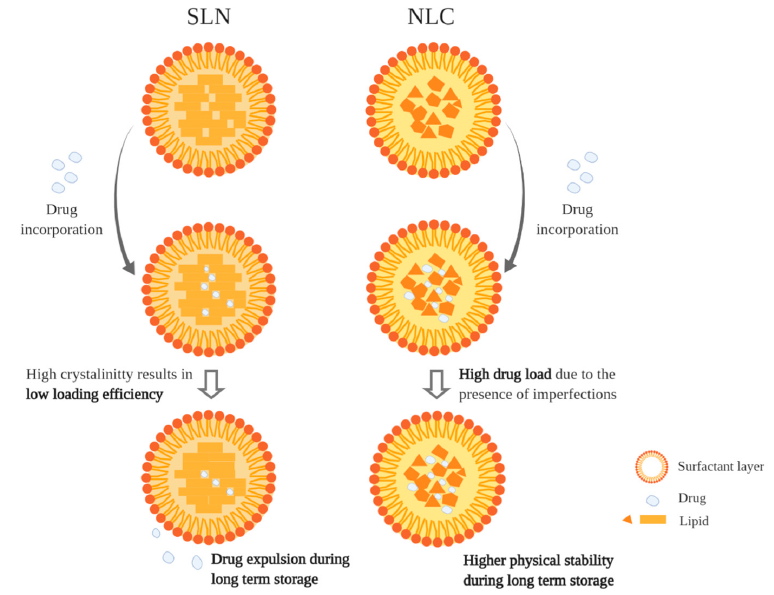
Figure 2. Difference between SLN and NLC loading efficiencies (adapted from [57] ). Figure 2. Di ff erence between SLN and NLC loading e ffi ciencies (adapted from